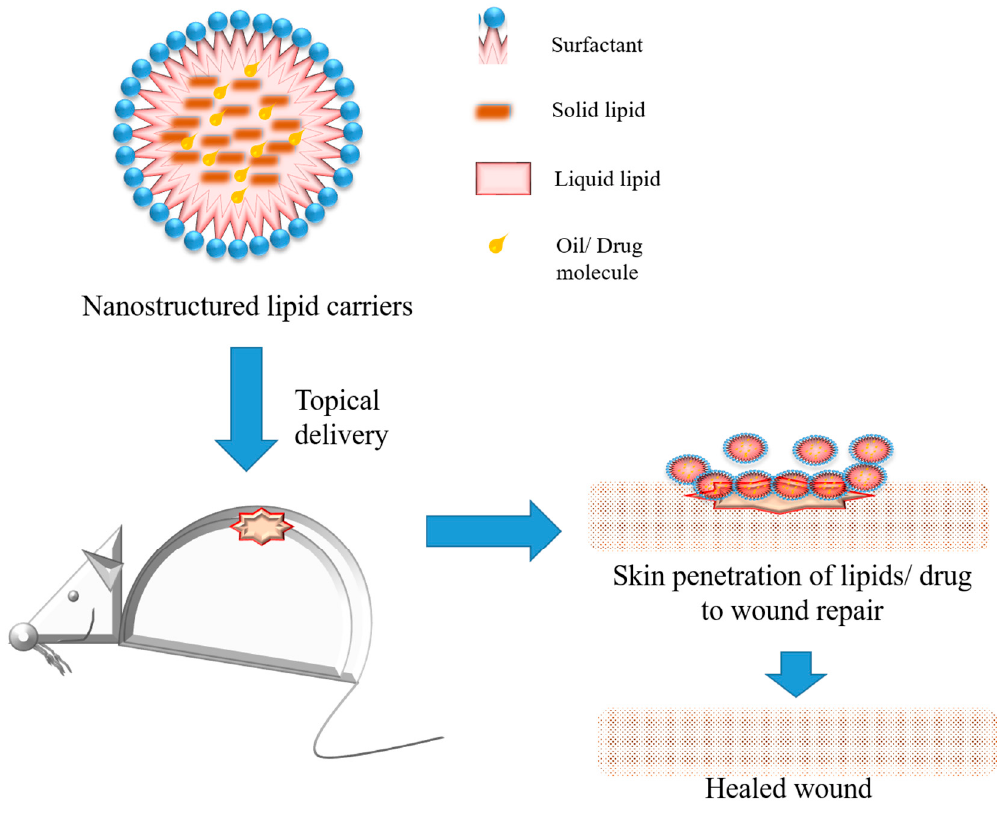
Figure 4. Schematic representation of nanostructured lipid carriers, their composition, and application for wound healing on rat model.